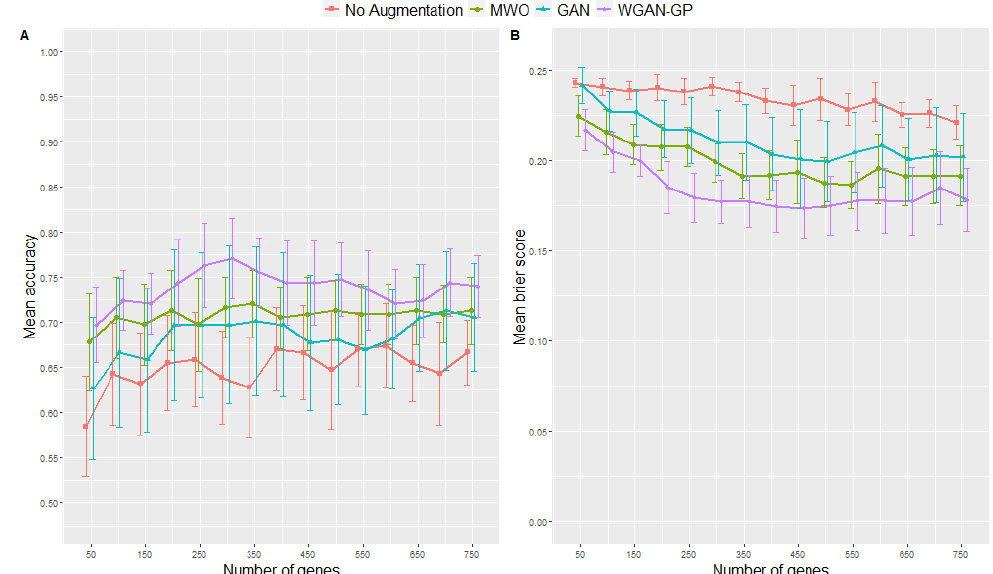
Figure 5. Cross validation classification accuracies ( A ) and Brier scores ( B ) for the RNA-seq experi- ment for different augmentation methods and various numbers of input features. Error bars represent the 95% confidence interval of the mean.